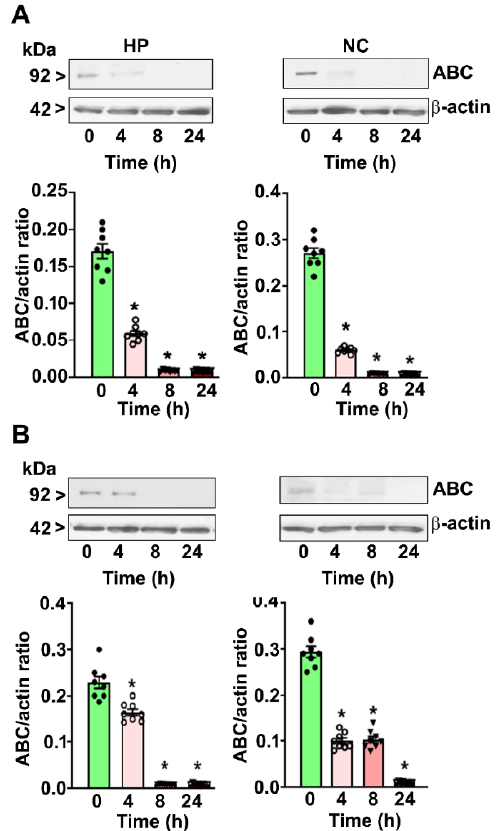
Figure 3. Reduced nuclear ABC protein levels in the P7 mouse HP and NC tissues in response to moderate- and high-dose ethanol exposure. The HP and NC nuclear extracts obtained 4–24 h after the first saline or moderate-dose ( A ) / high-dose ( B ) ethanol exposure. The ABC protein levels were analyzed using Western blot analysis. The protein samples were equally loaded, confirmed with Ponceau S staining, and normalized to β -actin. For the 0 h ethanol group, saline was administered. Error bars, SEM (* p < 0.05 vs. the saline [0 h] group, n = 8 pups/group).